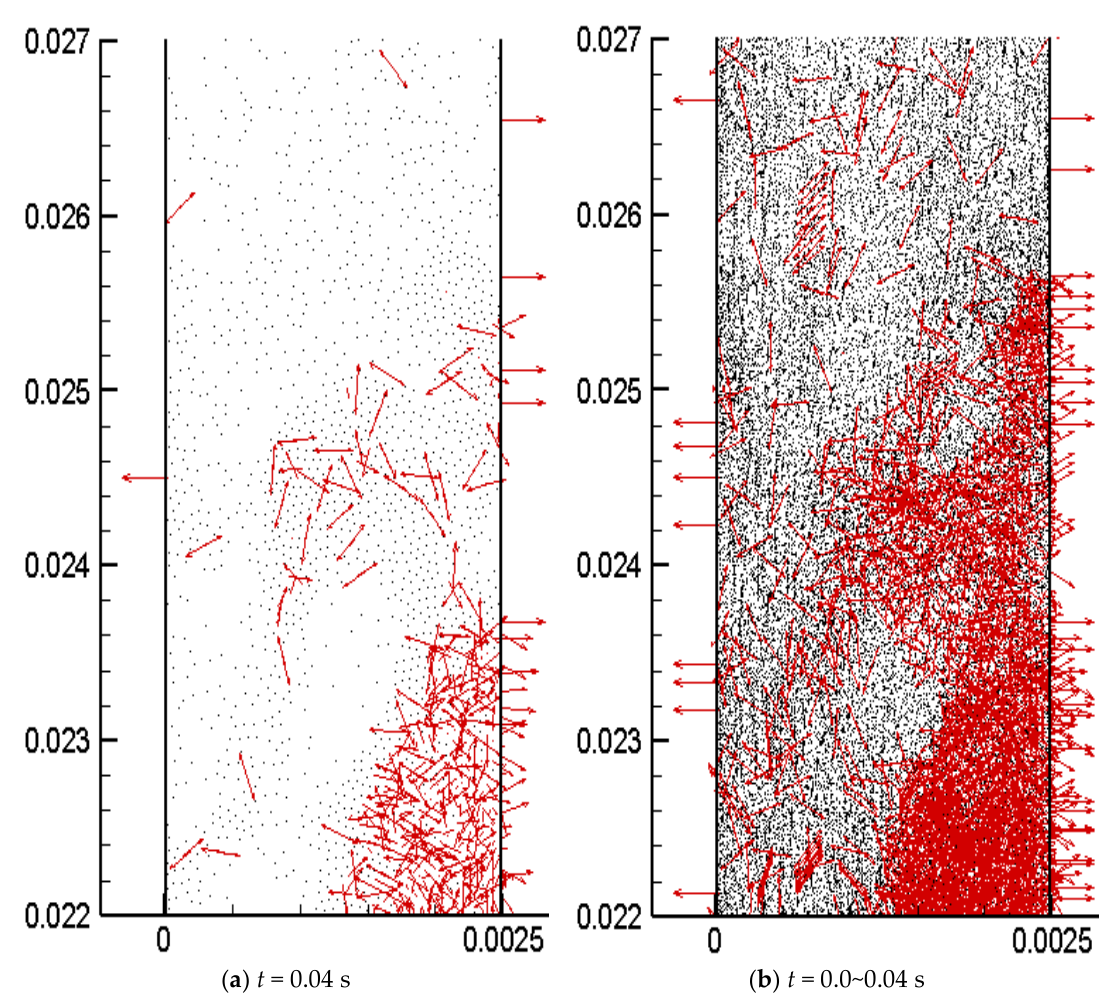
Figure 5. Sectional van der Waals force distribution with grid number 10 × 40.